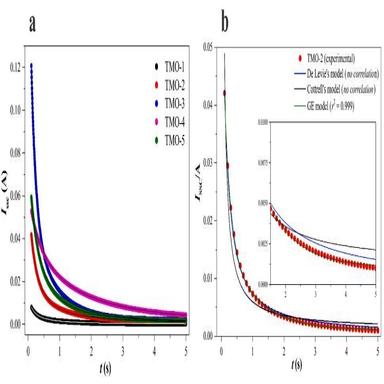
Transient currents (ISSC) as a function of the TMO composition and the simulations using the GE model (a) and the transient current obtained for the TMO-2 (b) electrode. These findings were also simulated in (b) using De Levie and Cottrell's models. Conditions: Estep = 400 mV. Electrolyte: 1.0 M H2SO4 (25 ◦C).